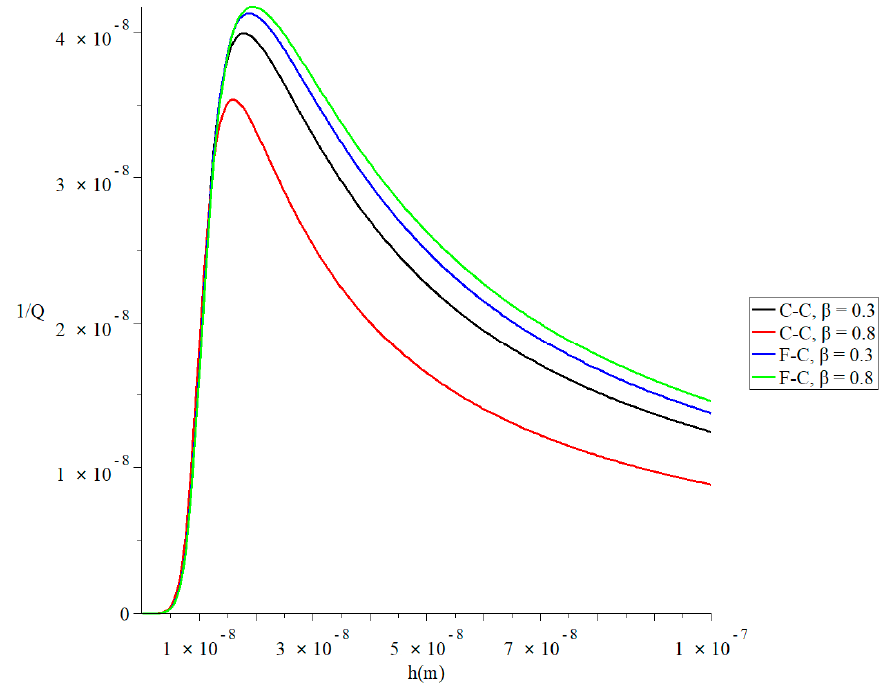
Figure 5. The thermal quality factor is based on the Tzou model with various fractional derivative types when L = 50 h , b = 4 h , q = 4.73/ L , and F = 10 − 40